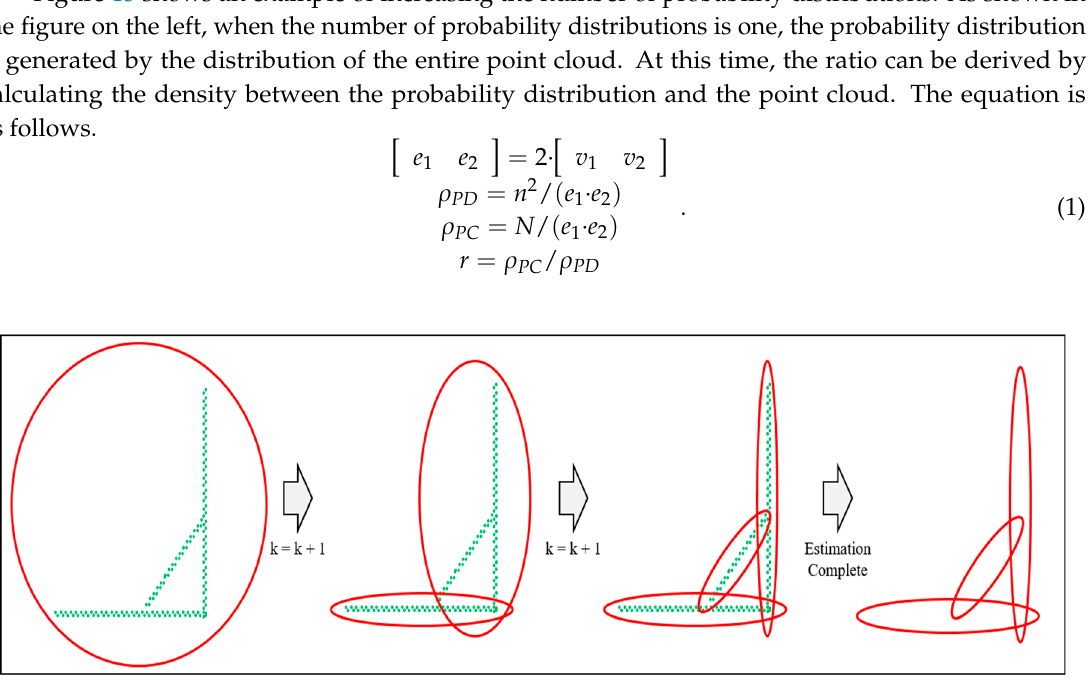
Figure 14. Pseudocode of the expectation–maximization (EM) algorithm for Gaussian mixture modeling (GMM).